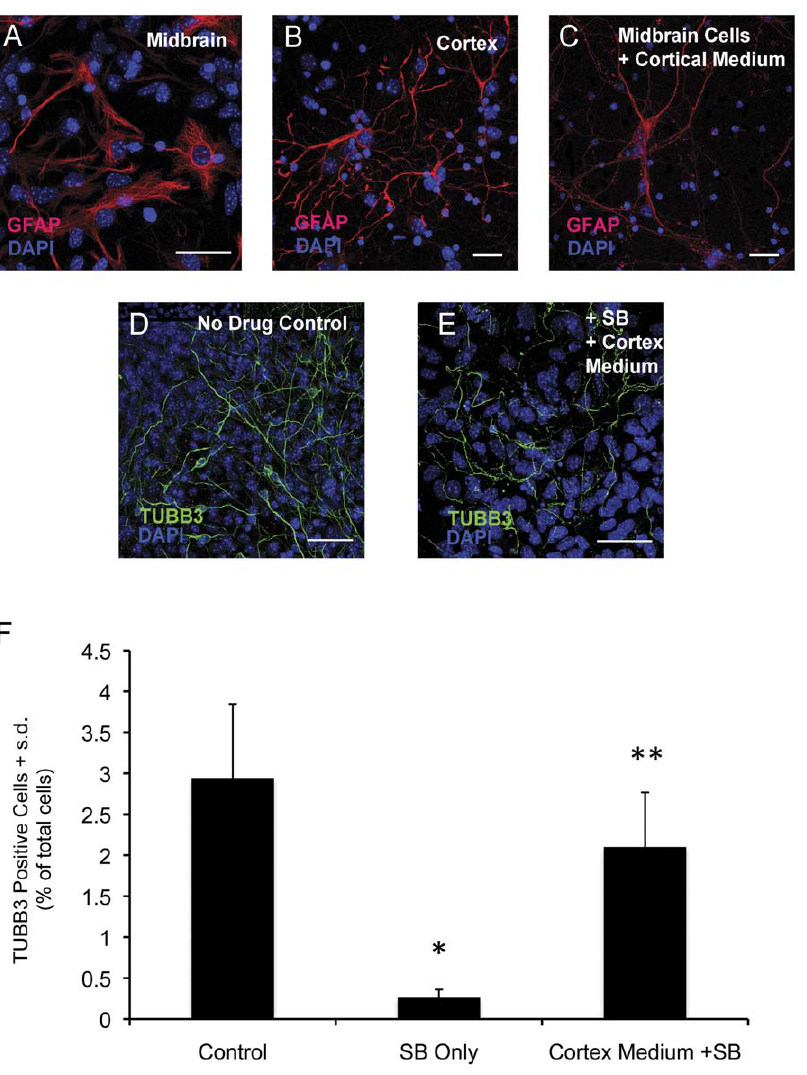
Figure 1. Microenvironmental factors in midbrain versus cortical cultures. (A) Protoplasmic GFAP positive astrocytes predominate in midbrain cultures. (B) GFAP positive astrocytes typical of cortical cultures, which display a filamentous morphology. (C) GFAP positive midbrain astrocyte cultured in cortical medium. Under cortical conditions midbrain derived astrocytes take on a filamentous morphology. (D) TUBB3 positive midbrain neurons cultured in 10% FBS for 14 days and then exposed to cortical medium alone for 48 hours. (E) TUBB3 positive midbrain neurons cultured in 10% FBS for 14 days and then treated with 50 mM SB in cortical medium for 48 hours. (F) Quantitation of the effect of different medium conditions on the TUBB3 positive neurons. Midbrain cells were cultured in 10% FBS for 14 days and then treated with 50 mM SB for 48 hours in the presence of cortical medium or 50 mM SB in 10% FBS. Bars represent the mean + s.d. (n=5). Single asterisk (*) denotes treatment groups that are significantly different from the untreated control, as determined by an unpaired Student’s t-test (p , 0.05). Double asterisks (**) indicate treatment groups that are significantly different from the SB only treatment group. Scale bars=50 m M. Blue= DAPI positive nuclei, red= GFAP, green= TUBB3.